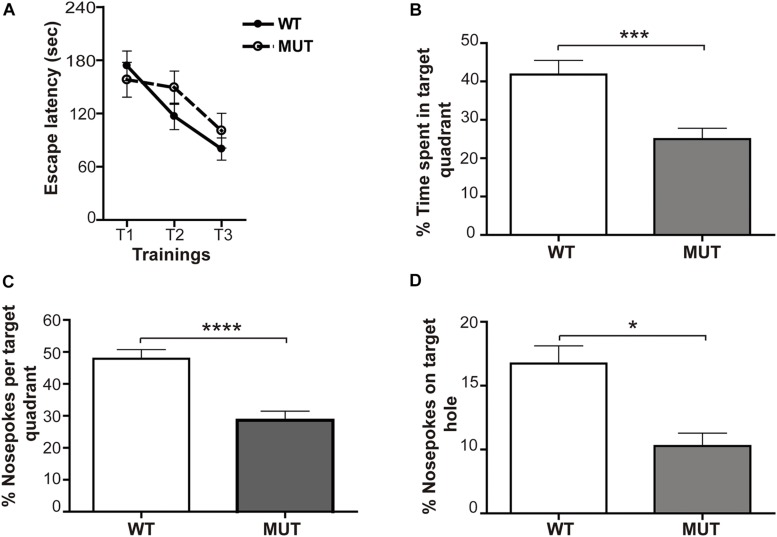
Mecp2-mutant mice show defective spatial memory evaluated through the Barnes maze. (A) Learning: the acquisition was reflected by lower escape latencies along the trainings. For both experimental groups, a similar decrease in the escape latency time (measured in seconds) throughout the successive trainings was observed. n = 16-19 mice per experimental group. Data analysis: two-way ANOVA followed by Tukey’s HSD test. (B–D) Memory: relative percentage of time spent and number of snouts made by the animals in the target quadrant and in the escape hole during the 2 min of the final memory test. (B) Percentage of time spent in target quadrant for WT and MUT mice. The analysis shows that WT mice spent significantly more time in the target quadrant than MUT mice. Percentage of snouts in the target quadrant holes (C) and in the escape hole (D) in relation to the total snouts performed in the holes of the platform in the 2 min of the final memory test. Both the percentage of snouts in the “target” quadrant (C) and in the escape hole (D) was significantly higher in WT mice when compared with the MUT. n = 16–19 mice per experimental group. Data analysis: Mann–Whitney t-test with 95% confidence interval. *p < 0.05; ∗∗∗p < 0.001; ****p < 0.0001.